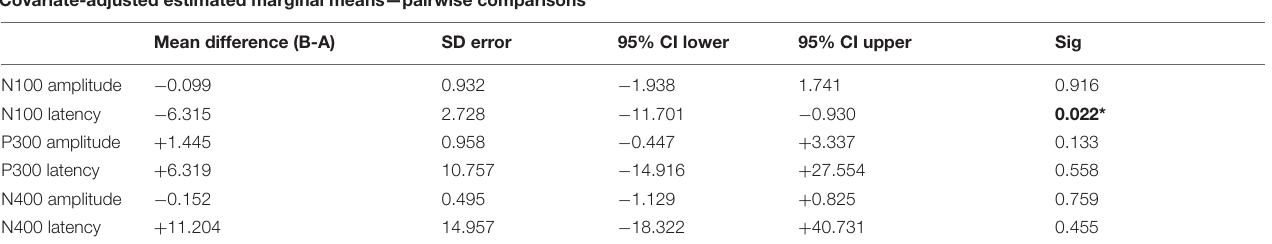
brain injury. As detailed in Figure 3 , the radar plots of a concussed athlete represent a deviation from the “normal”